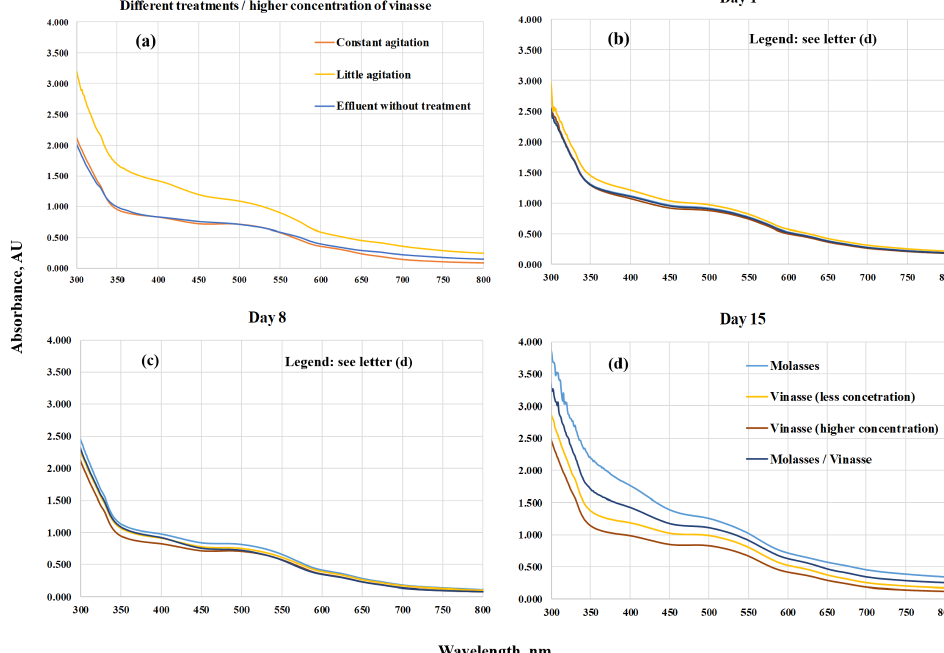
Figure 2 - UV-Vis absorbance spectra for the tests with textile industrial waste enriched with vinasse and molasses, under the action of microorganisms of leachate. Comparison of tests with vinasse in lower concentration relative to the other types of treatment (a) and comparison among tests with different sources of nutrients throughout the experiment (b) , (c) , and (d)